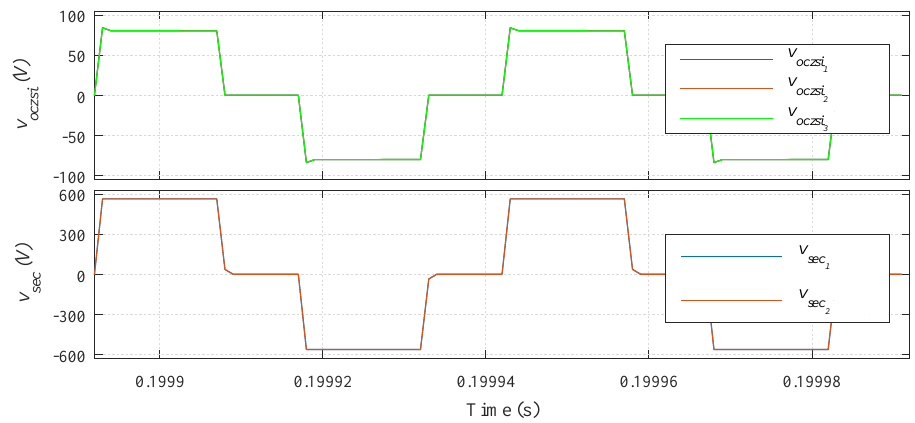
Figure 9. Simulation results: CZSI modules output voltages v oczsi voltages v sec and v sec under unbalanced 2 1